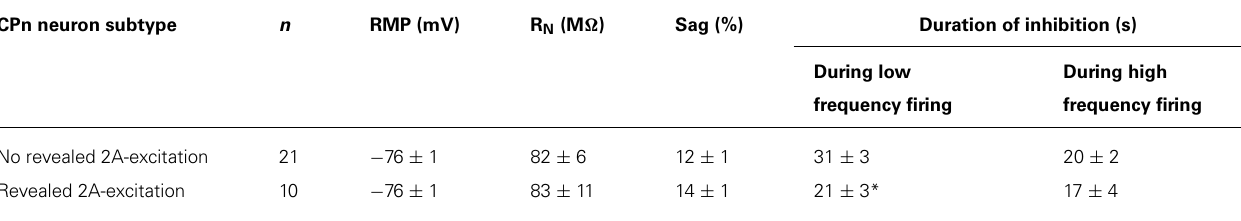
FIGURE 8 | 5-HT does not facilitate glutamate-driven excitation in COM-biphasic L5PNs. (A) Responses of a COM-biphasic L5PNs to five suprathreshold (top traces) or subthreshold (bottom traces) applications of glutamate in baseline conditions (blue), immediately after 5-HT application (red), and approximately two minutes after 5-HT application (“wash”; green). Dashed-lines indicate RMP. (B) Plots of the number of action potentials (APs;